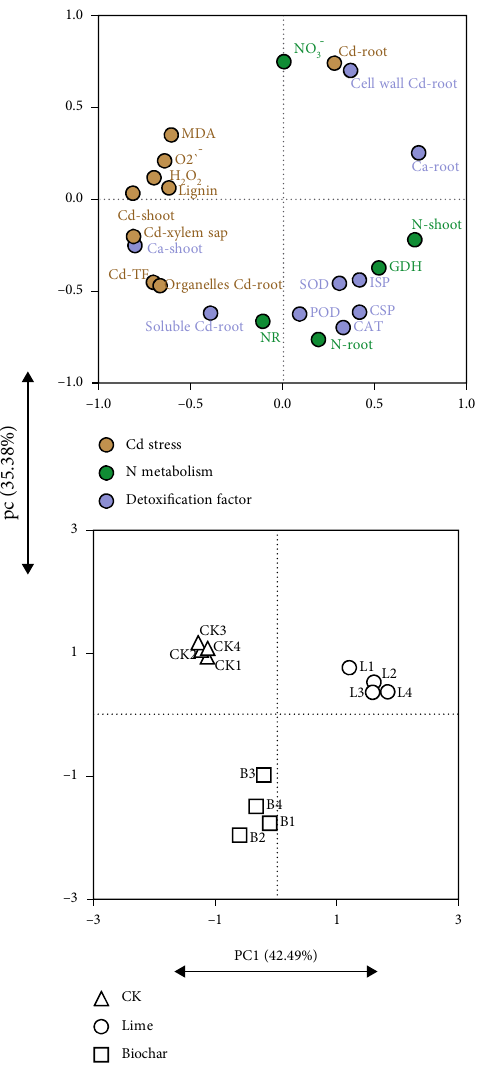
Figure 4: Principal component analysis. Principal component analysis for (a) the 23 traits and (b) the 3 treatments for the fi rst two axes. ISP: ion-bound pectin; CSP: covalently bound pectin; - · : MDA: malondialdehyde; H O : hydrogen peroxide; O 2 2 2 superoxide anion; SOD: superoxide dismutase; CAT: catalase; POD: peroxidase; NO 3- : nitrate; NR: nitrate reductase; GDH: glutamate dehydrogenase; and TF: translocation